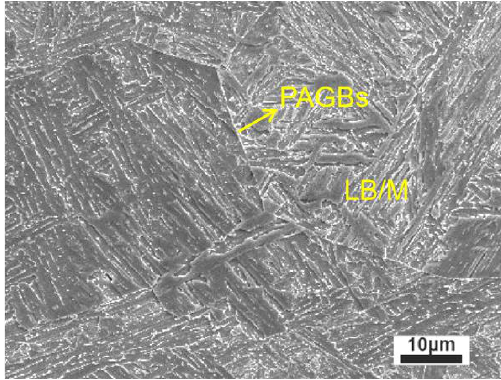
Figure 2. Microstructure of CGHAZ observed by SEM.